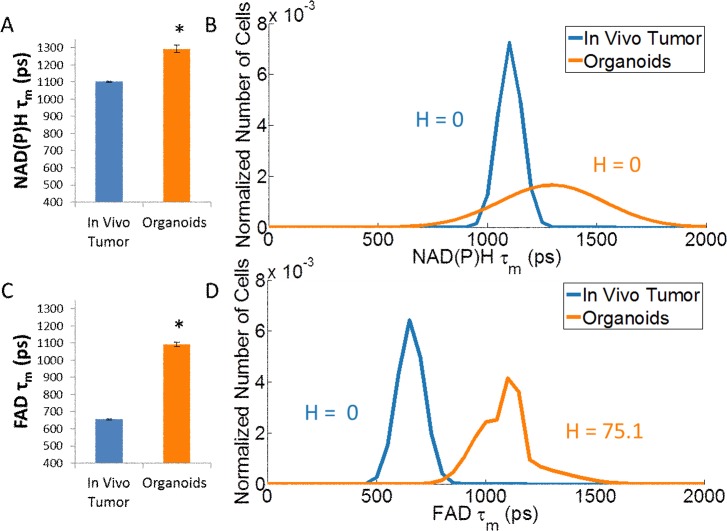
Untreated organoids and in vivo tumor tissue display distinct optical metabolic imaging properties.The weighted mean is calculated by τm = α1τ1 + α2τ2, where τ represents the lifetime value and α represents the contribution from each component. (A, C) Organoids exhibit higher NAD(P)H and FAD fluorescence lifetimes (τm) compared with in vivo tumor tissue, which is explained by lower contributions of the short lifetime component (α1), higher values of the short fluorescence lifetime (τ1), and higher values of the long fluorescence lifetime (τ2) (See S1 Fig). (B, D) Population distribution analysis plots cellular heterogeneity for in vivo tumor tissue compared with organoids. The heterogeneity index (H) is similar between organoids and in vivo tumor based on the NAD(P)H fluorescence lifetime and increases for organoids compared to in vivo tumor based on the FAD fluorescence lifetime. The in vivo data is a subset of data published in [28]. *p<0.05, t-test, n~100–300 cells per group.